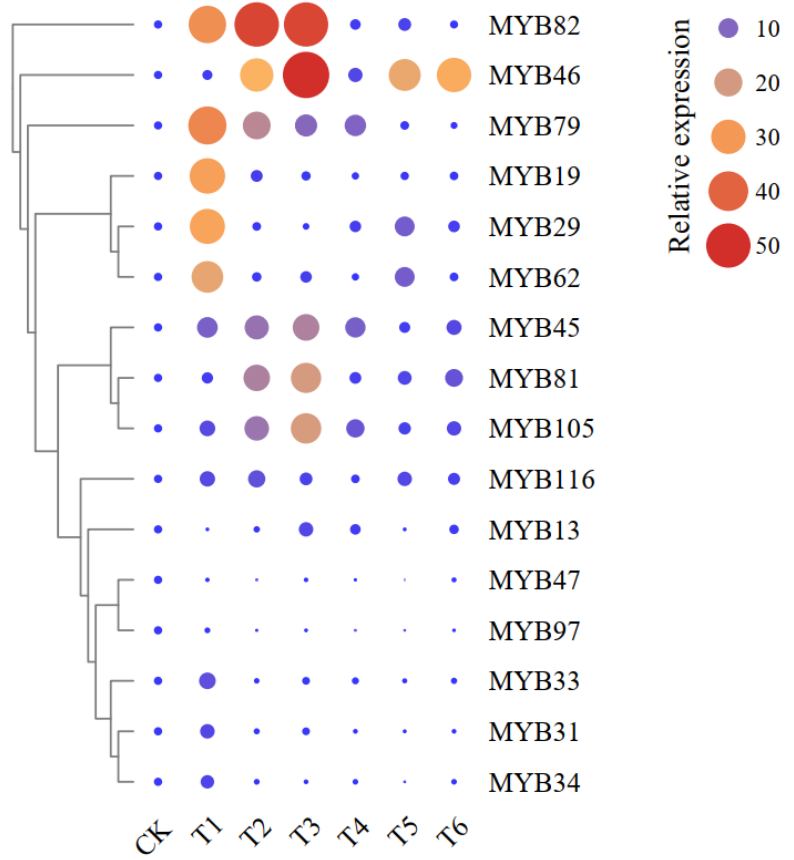
Figure 2. Relative expression levels of 16 CsMYB genes under different treatments. The circle sizes represent relative expression values of the CsMYB genes.